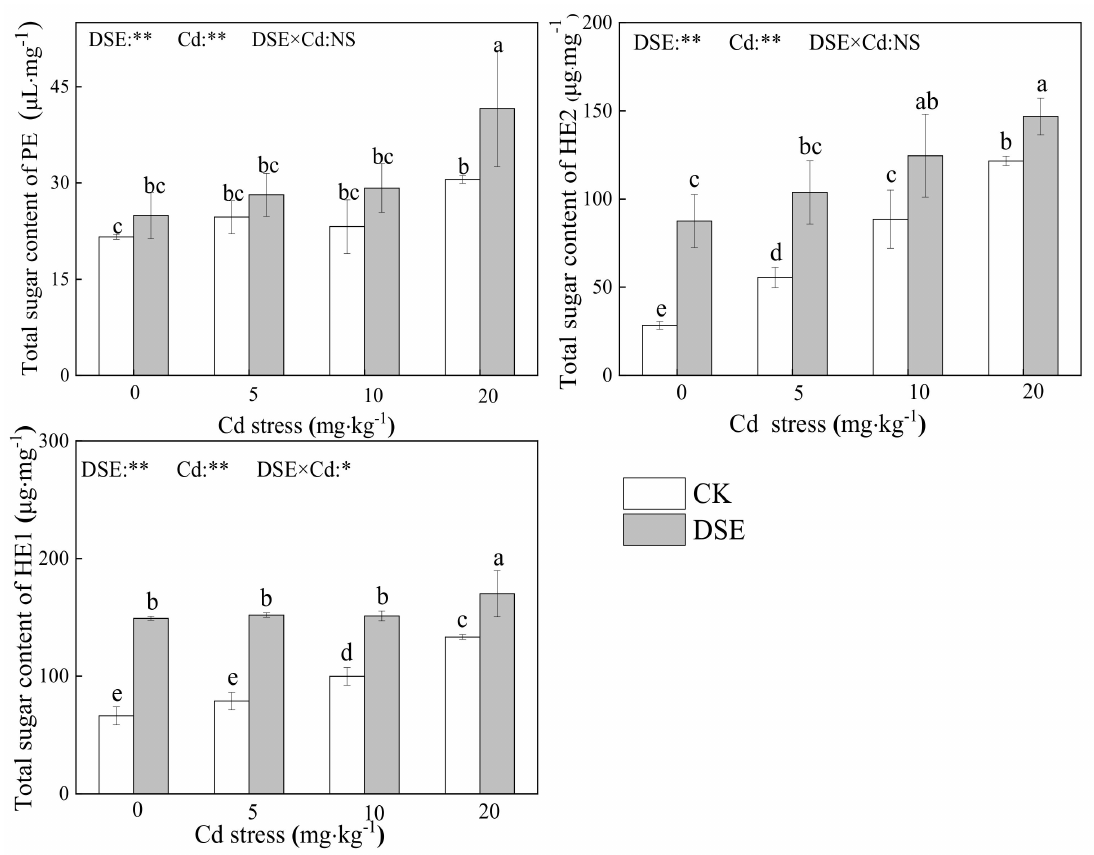
Figure 3. Total sugar content of pectin (PE), hemicellulose–1 (HE1), and hemicellulose–2 (HE2) in maize RCW with DSE- inoculated and Cd stress. Error bar indicates standard deviation. Cd: cadmium treatment; CK: the control of non-inoculation; DSE: Exophiala pisciphila inoculation; different little letters refer to p < 0.05 according to LSD test. “NS”, “*”, and “**” mean no significance, p < 0.05 and p < 0.01 according to two-way ANOVA,